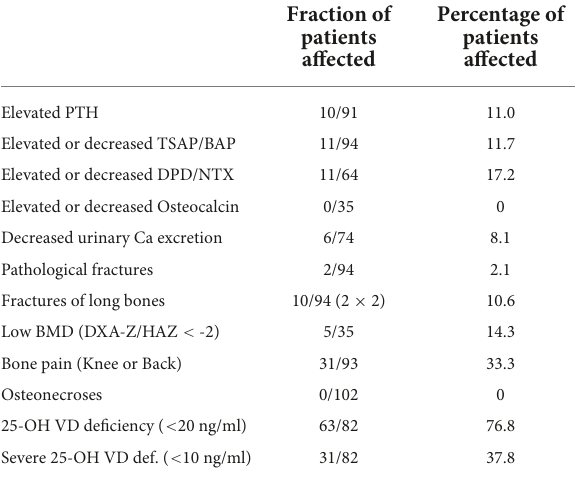
TABLE 3 Frequency of aberrant findings suggesting impaired bone health.